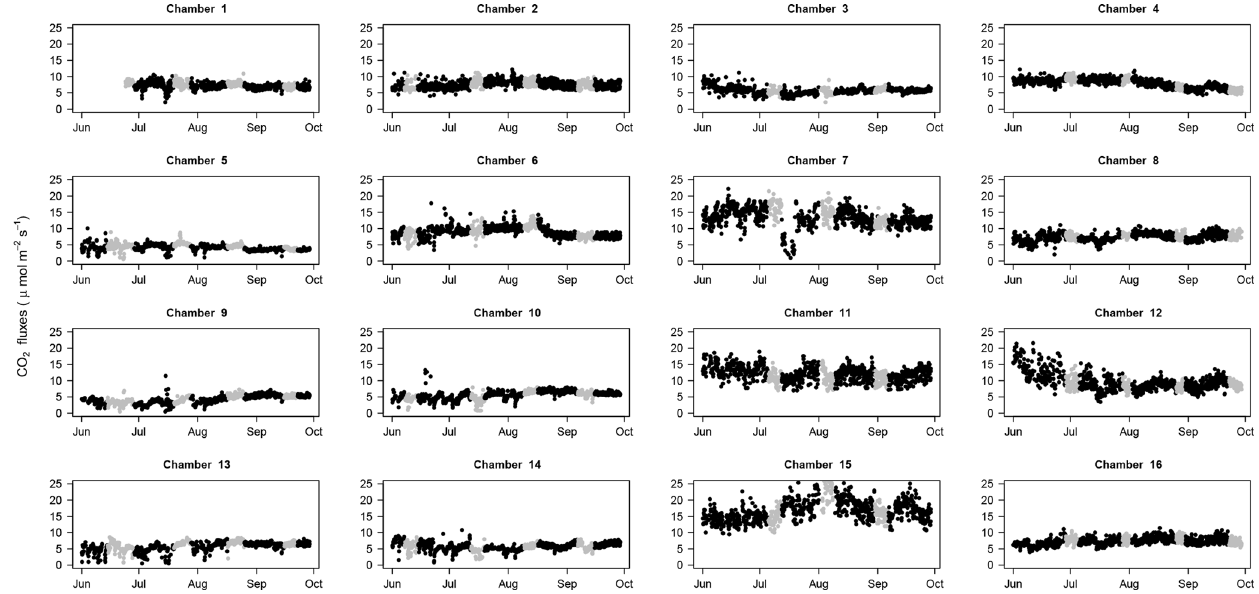
Figure 4. CO 2 fluxes through time: CO 2 fluxes for each chamber (1 to 16) over the study period with fluxes estimated with a SHORT (2min) closure time in black and fluxes estimated with the first 2min of the LONG (25min) closure time in grey. All panels have the same limits on the y axis (from 0 to 25µmolm − 2 s − 1 ).